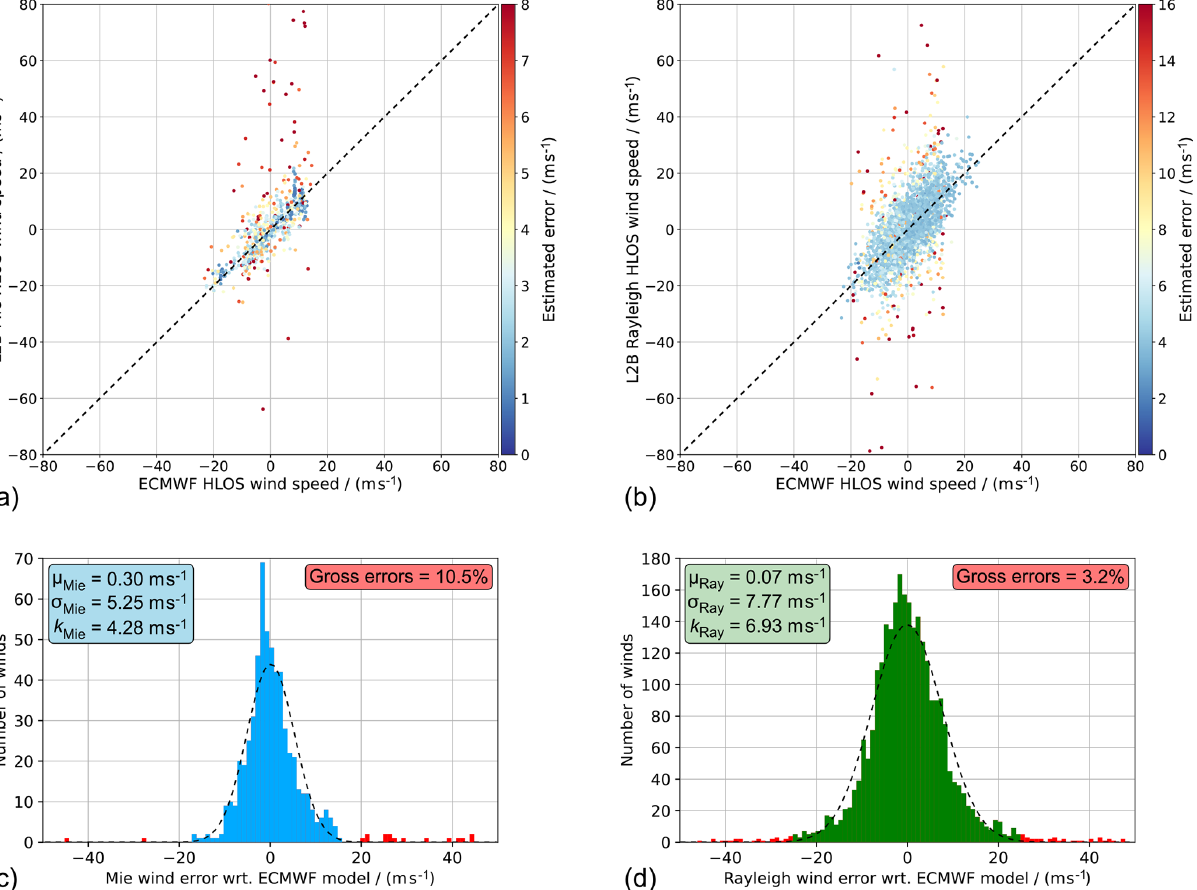
Figure 2. Scatterplots comparing the L2B Mie-cloudy (a) and Rayleigh-clear (b) wind results against ECMWF model winds from the 11 underflights of the AVATAR-T campaign. The colour-coding describes the L2B EE of the wind results. The statistical parameters without and with outlier removal, using the modified Z score, are given in Table 2. (c, d) Histograms of the respective wind errors (L2B minus ECMWF model) in bins of 1ms − 1 . The red bars indicate gross errors, as identified by the modified Z score. The dashed lines represent Gaussian fits of the error distributions after outlier removal. The statistical parameters after outlier removal are given in the insets.